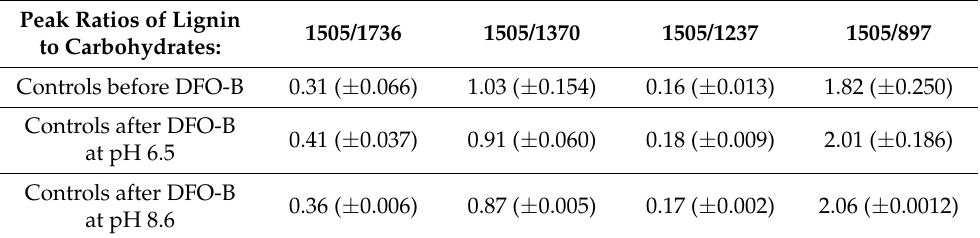
Table 2. Average ratios of the areas under the band maxima of aromatic lignin peak (1505 cm − 1 ) to typical carbohydrate peaks of wood (1736 cm − 1 , 1370 cm − 1 , 1237 cm − 1 and 897 cm − 1 ) of four replicates before and after 8 DFO-B hydrogel applications.